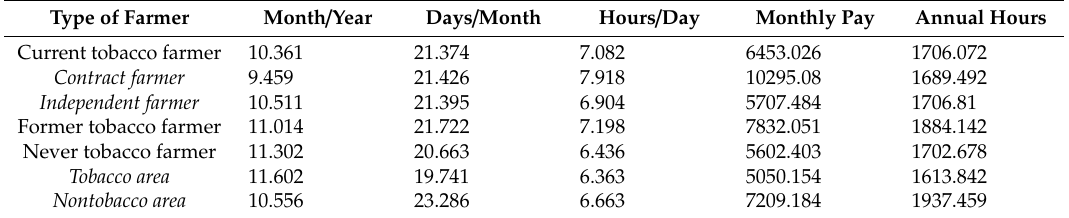
Table 6. Average non-farm employment (hours) and monthly income (BDT) of